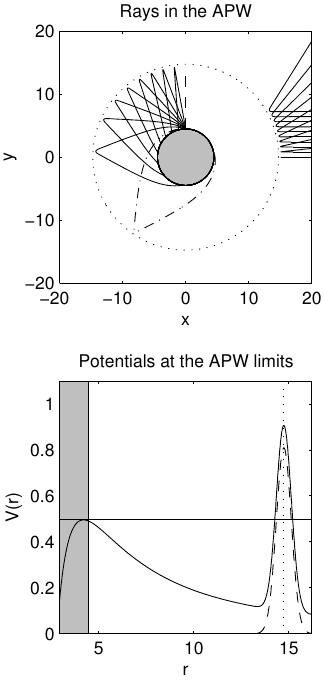
Figure 5. Trapped and scattered rays in the APW. The upper panel plots the paths of 10 rays emitted from the CO surface, R , at φ = π /2. These rays are evenly spaced between L = 0 (dashed), and L max (dashed-dotted). Also plotted are the paths of 10 rays that approach the ECS externally from the + x direction, and are reflected by the potential boundary. These external rays are plotted as the solid black curves. The ECS radius is the dotted circle. The lower panel shows the corresponding effective potential for the bound rays L = 0 (dashed) and 0.99 L max (solid). The square of the asymptotic frequency ω 2 ∞ is the horizontal line. The shaded region is the CO interior, and the vertical dotted line is the ECS radius. Both interior and exterior radially directed rays ( L = 0) have frequencies ω ∞ = ω ∞ p . These rays, and all rays with lower frequency, cannot propagate through the